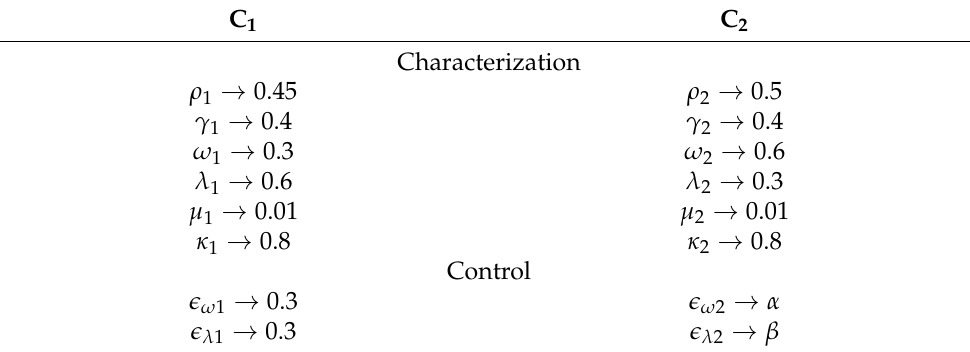
Table 3. Parameters used in simulations to create different